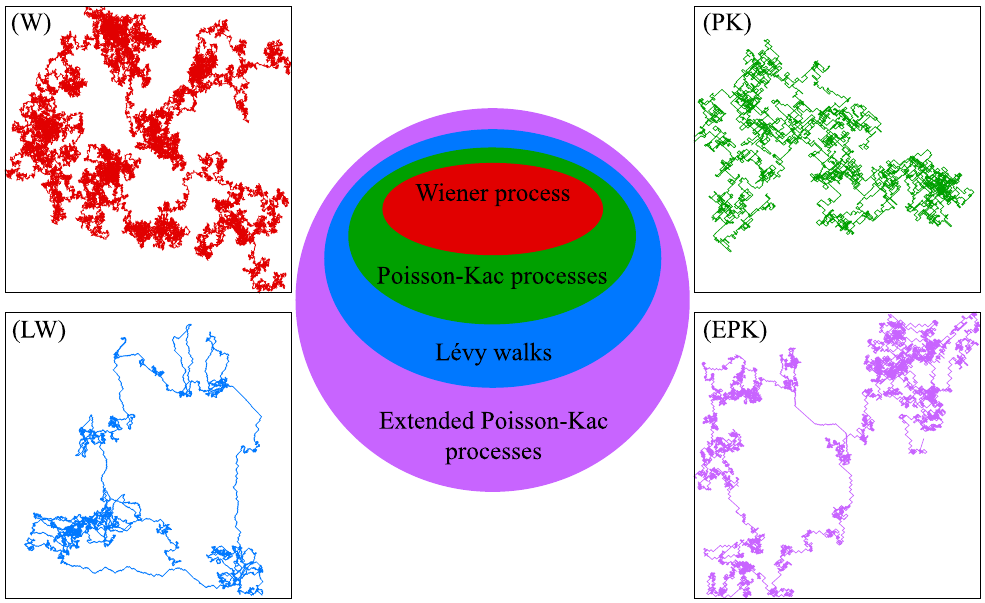
FIG. 1. Schematic representation of the increasing level of generalization in stochastic kinematics with finite propagation speed, from Wiener processes (W), to Poisson-Kac processes (PK), to L´evy walks (LW), and finally to extended Poisson-Kac processes (EPK). The latter define the new class of stochastic models introduced in Sec. III. Overlapping Poisson-Kac processes, which are discussed specifically in Sec. III B, are one particular instance of these processes. Example orbits of realizations of these processes in two spatial dimensions are shown correspondingly. For two-dimensional LWs, we simulate the two-state model (see Sec. II C) with the transition rate Eq. (7) where ξ ¼ 1 . 5 . For the class of EPK processes, we choose a senescent LW (see Sec. IVA) with ξ ¼ 1 and τ 0 ¼ 1